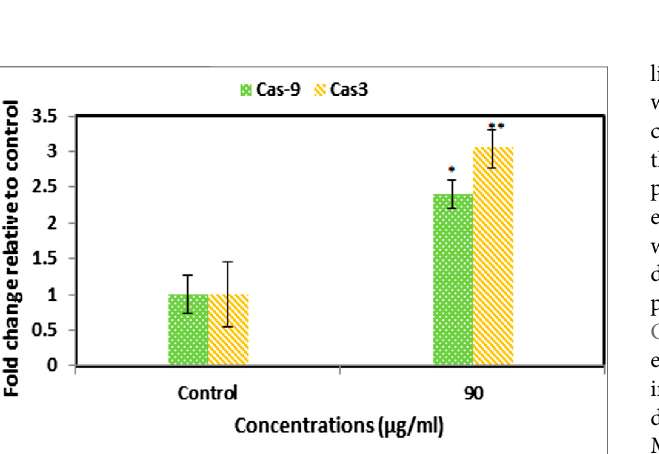
Frontiers in Chemistry |